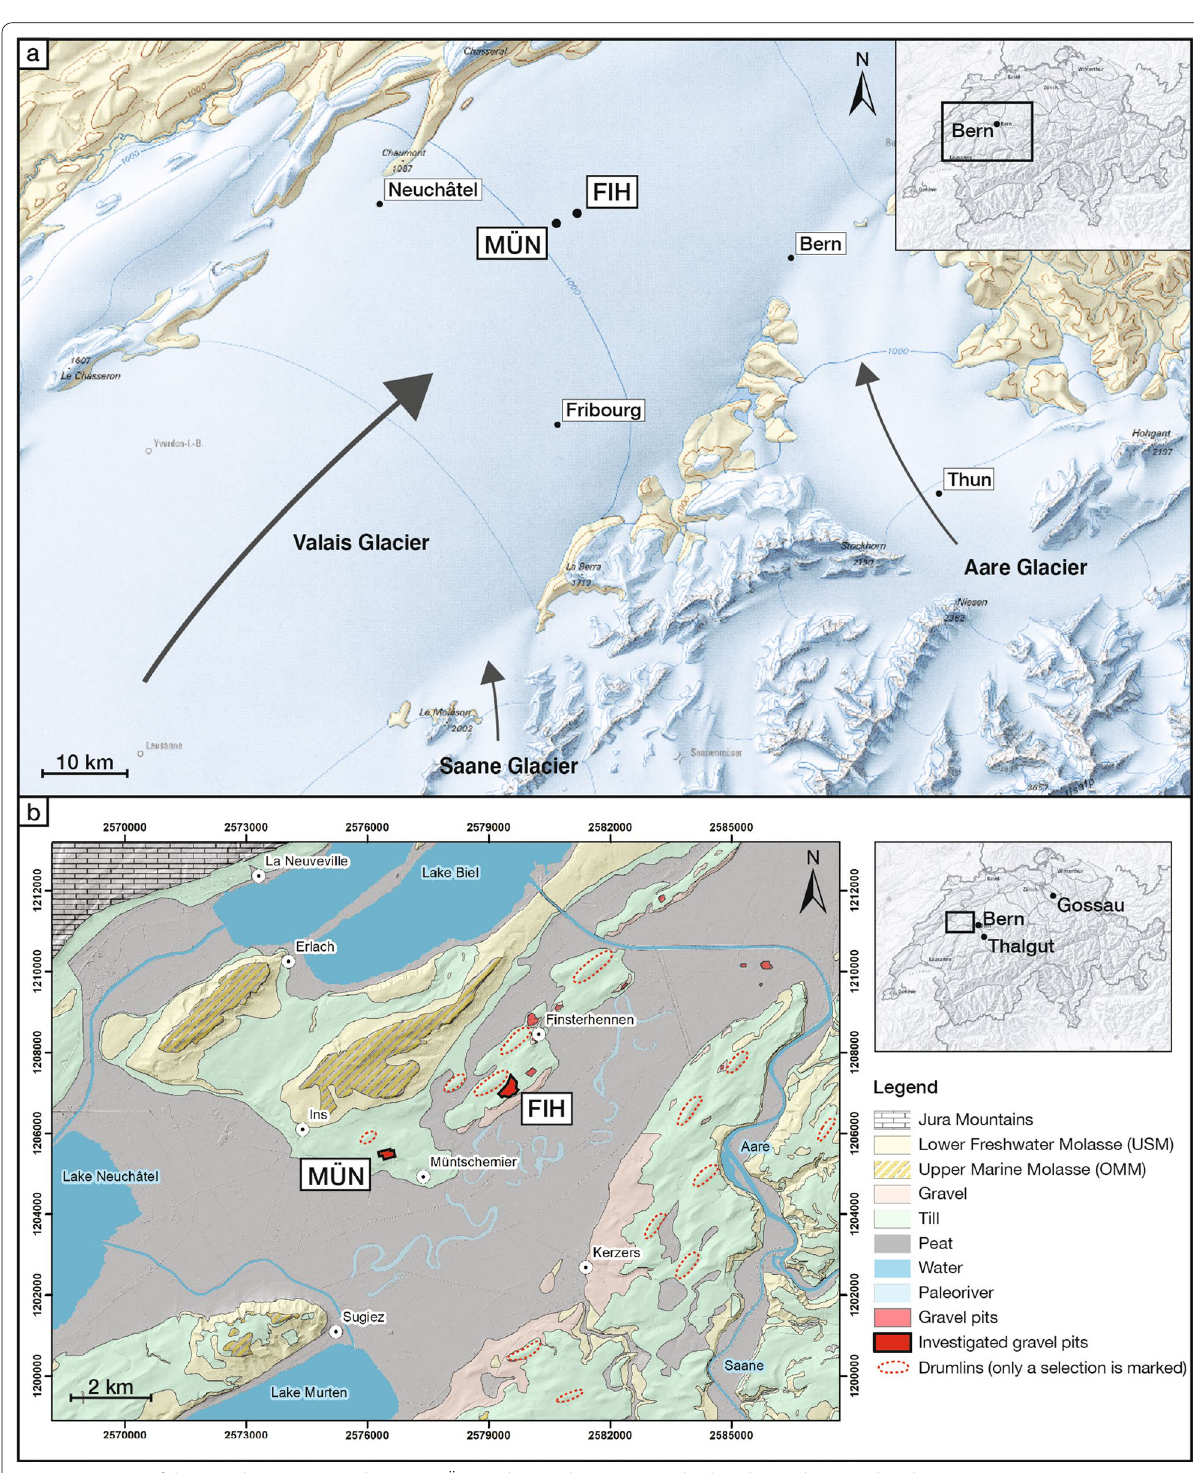
Fig. 1 Location of the gravel pits at Müntschemier (MÜN) and Finsterhennen (FIH) displayed on a the Last Glacial Maximum (LGM) map (Bini et al., 2009) together with the lobes of the Valais, Saane, and Aare Glaciers (© Federal Office of Topography, swisstopo, CH-3084 Wabern) and b the geological